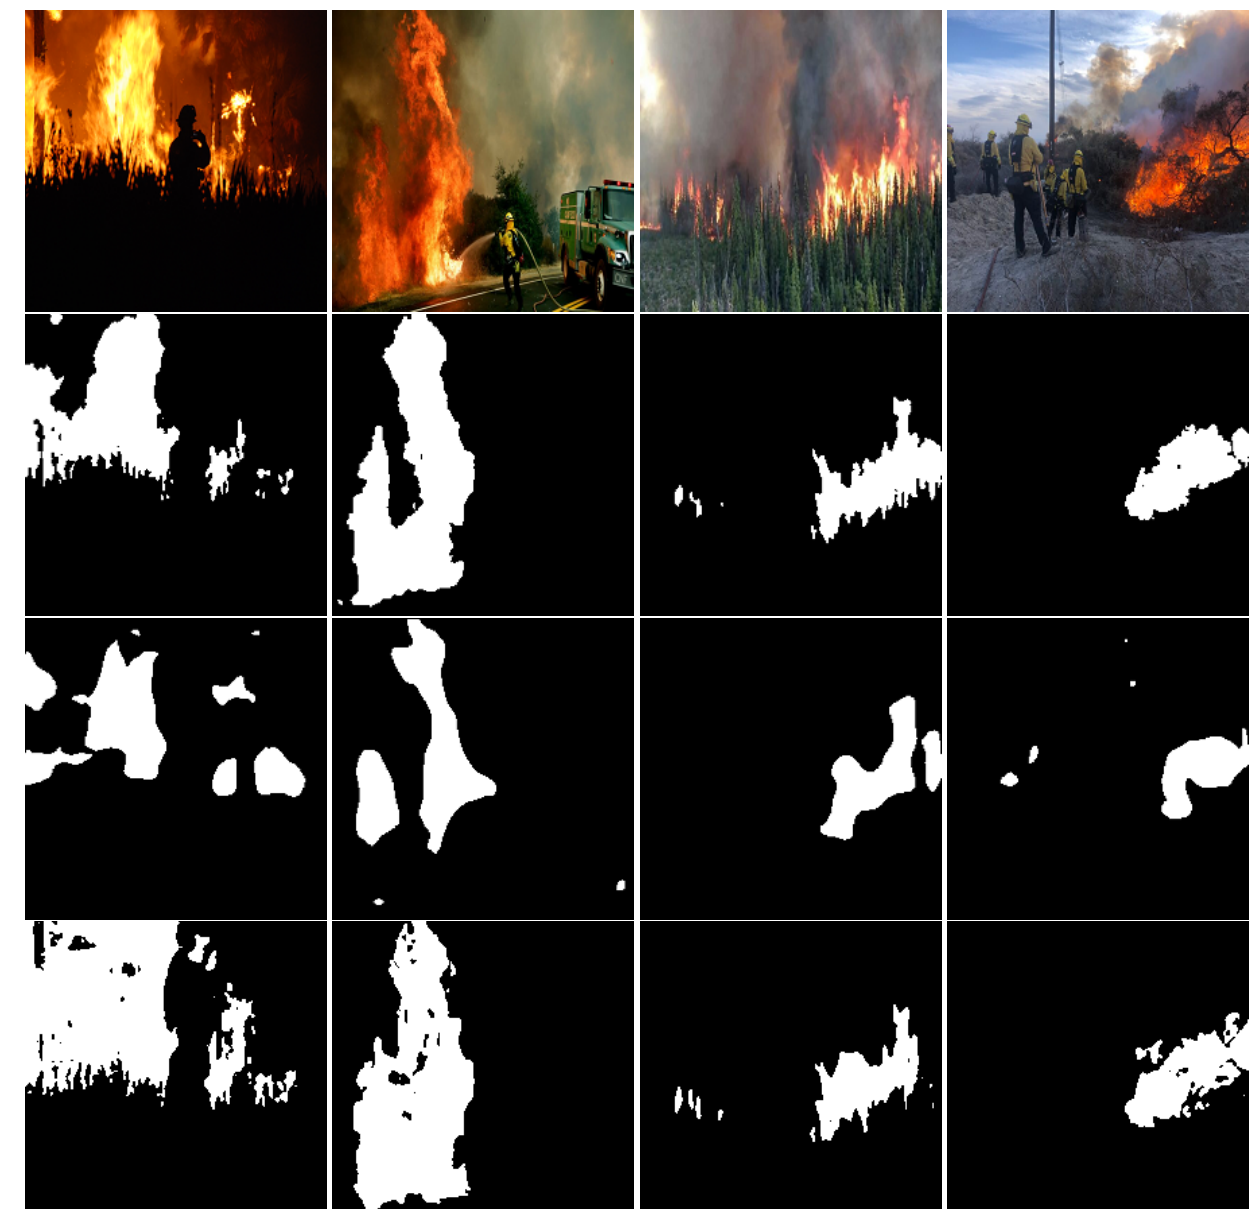
Figure 12. Results of TransUNet and MedT using web images. From ( top ) to ( bottom ): real RGB images, TransUNet-Res50- ViT results, TransUNet-ViT results, and MedT